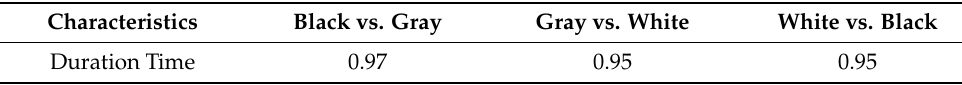
Table 6. The correlation coefficient of the duration for each background.